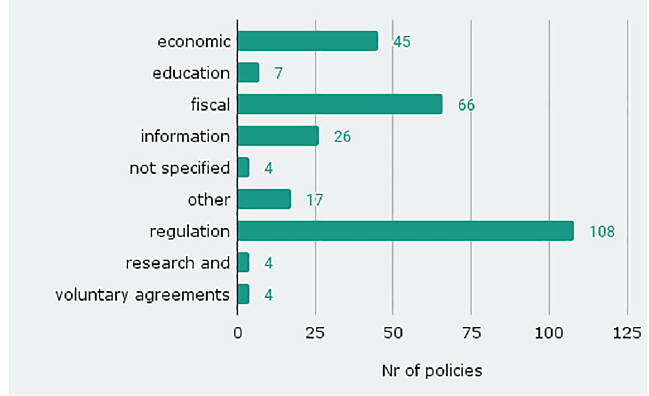
Figure 3. Number of policy instruments by instrument types.